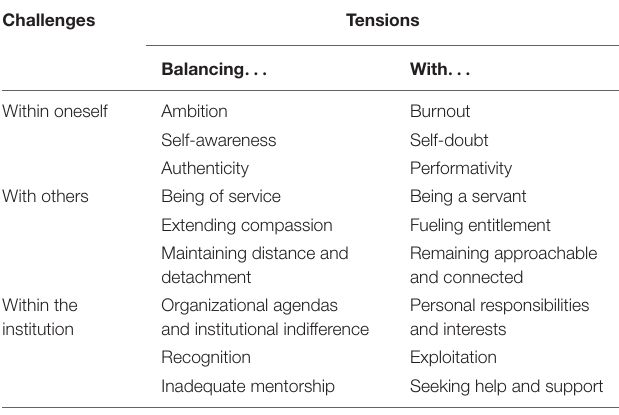
TABLE 2 | Challenges and tensions within women chairs’